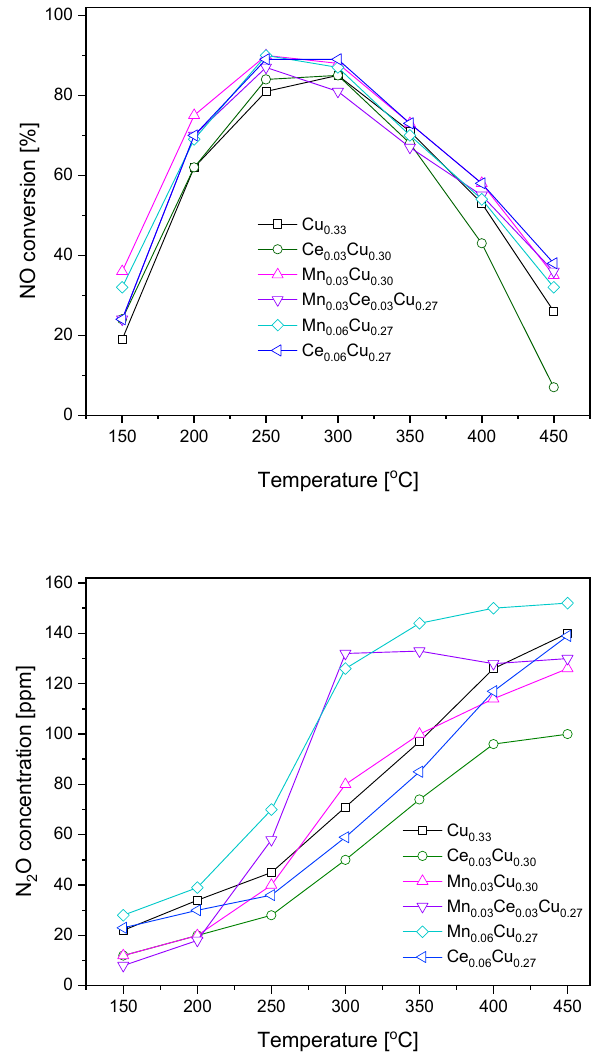
Figure 1. NO conversion and N 2 O formation over Cu–Al catalysts doped with manganese and cerium. During the catalytic tests, the concentration of N 2 O forming the undesired by-product was measured as well (Figure 1). Over the undoped catalyst, the concentration of N 2 O achieved 45 ppm at 250 °C and started to rise more rapidly above this temperature reaching a level of 140 ppm at 450 °C. The admixture of Ce resulted in significant lowering of N 2 O formation, namely, at 300 °C, the N 2 O concentration exceeded the detection limit of 30 ppm and reached 100 ppm at 450 °C. In the temperature range of 300–350 °C, the presence of manganese increased the formation of by-product in comparison to the Cu 0.33 sample; however, at higher temperatures (400–450 °C), the opposite was true. The equimolar Ce 0.03 Mn 0.03 Cu 0.27 catalyst caused the formation of 60 ppm of nitrous oxide at 250 °C, while above 300 °C, the concentration of N 2 O was constant at the level of 130 ppm. The increase of the Mn amount resulted in the highest N 2 O concentration in the whole temperature range. In the case of higher cerium content, the amount of N 2 O formed was about 10 ppm higher than over the Ce 0.03 Cu 0.30 sample up to 350 °C.